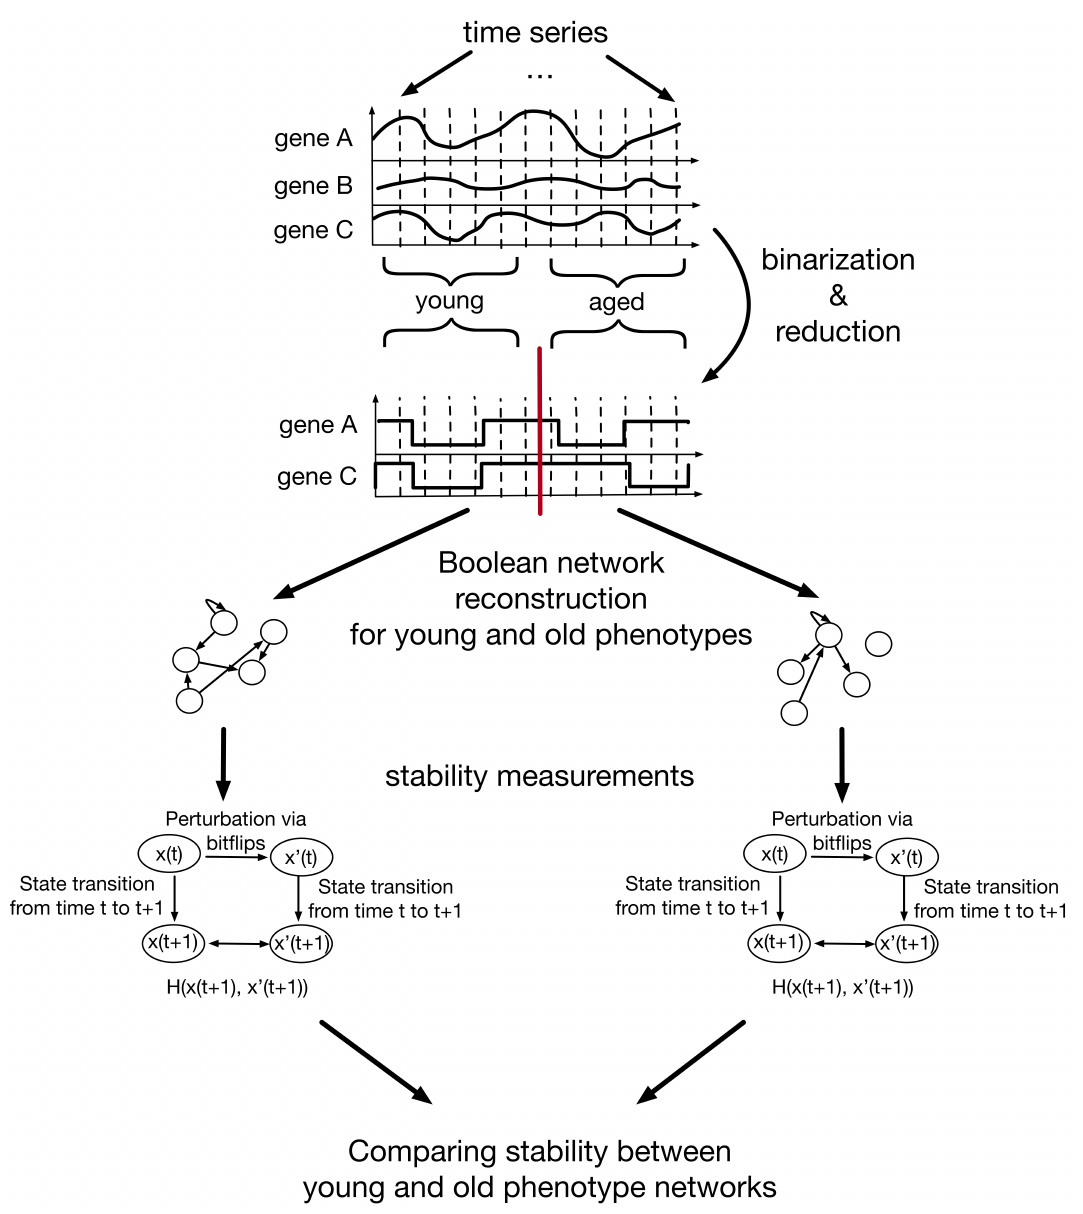
Figure 1. Schematic representation of a Boolean network approach to investigate stability changes in aging signaling networks. First, the time-series data is binarized and reduced using the BASC A algorithm of the R-package BiTrinA [20]. The resulting time-series data is split into two age groups (young ( n = 7) and aged ( n = 8)) and used to infer Boolean networks using the R-package BoolNet [21]. In the next step, the stability of the resulting Boolean networks is investigated by perturbation experiments. The best-fit algorithm can return a number of different Boolean functions for each gene in the network. From these possible functions 1000 synchronous Boolean networks are created for each age group by randomly drawing one of the inferred Boolean functions for each gene. Next, randomly generated states ( x ( t ) ) are perturbed using bitflips ( x (cid:48) ( t ) ). The normalized Hamming distance ( H ( x , x (cid:48) ) ) of the successor states x ( t + 1 ) and x (cid:48) ( t + 1 ) and x ( t + 5 ) and x (cid:48) ( t + 5 ) of x ( t ) and x (cid:48) ( t ) is computed. This is repeated for 1000 random states, the successor states of 1000 random states and random attractor state following 1000 random states with random bitflips. Finally, the mean normalized Hamming distance of these 3000 tests for each of the 1000 networks of each phenotype is